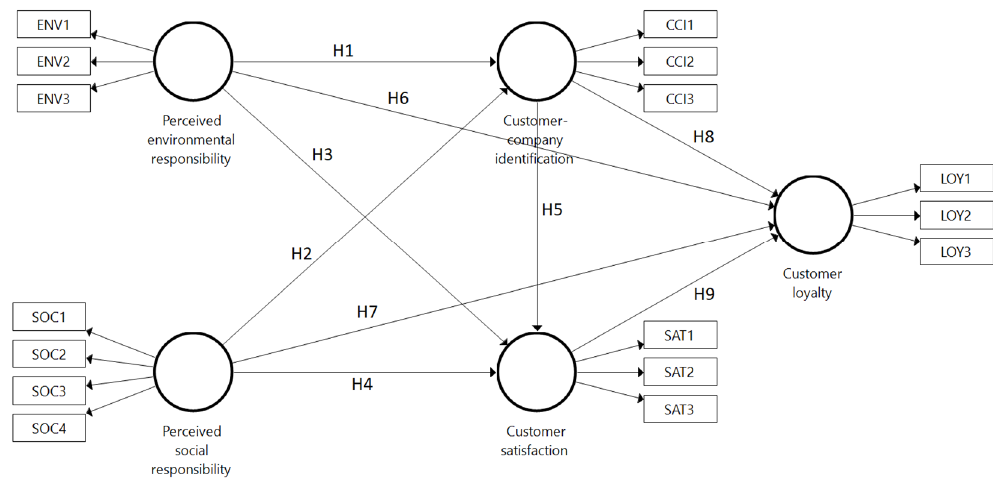
Figure 1. Research framework.